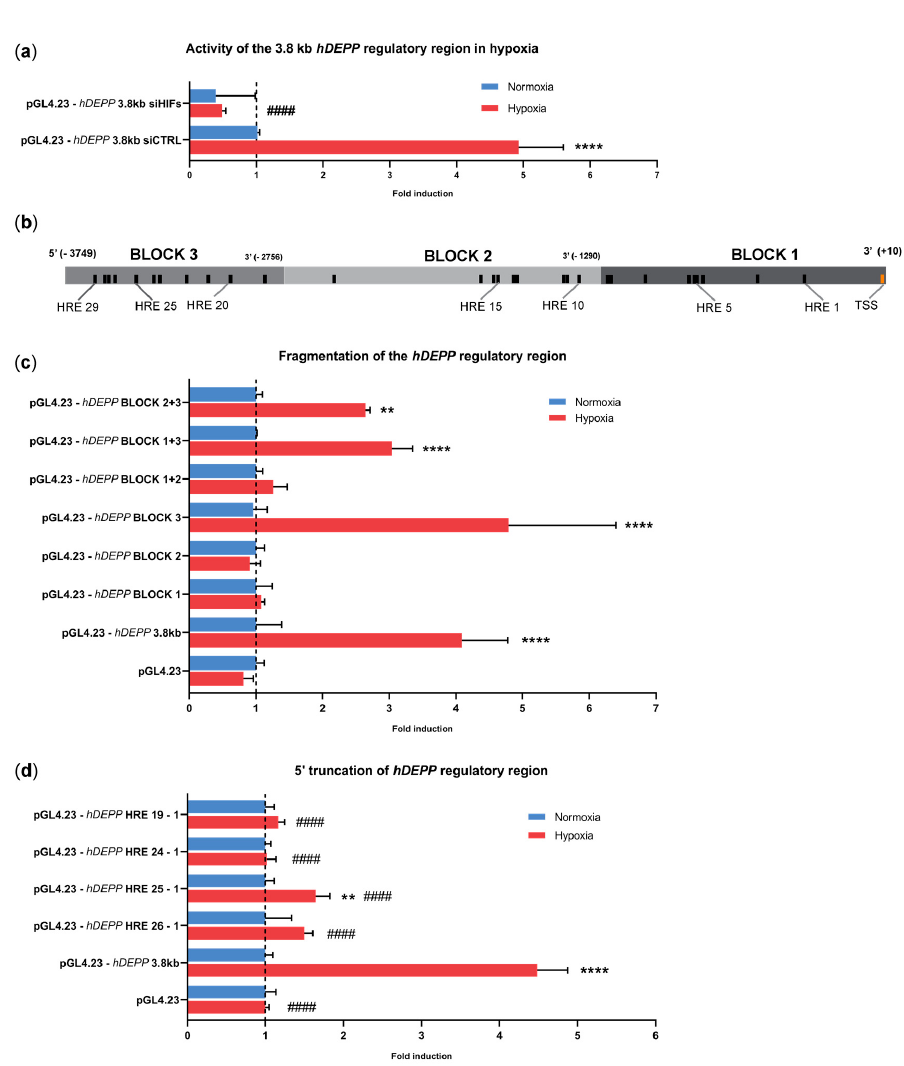
Figure 3. Hypoxic regulation by the 3.8 kb DNA fragment upstream of the DEPP transcriptional start site. ( a ) Luciferase activity driven by the 3.8 kb h DEPP regulatory region assayed in hypoxic and normoxic ARPE-19 cells. Cells were transfected with the reporter plasmid containing DEPP regulatory sequence and treated with scrambled siRNA (siCTRL) or with siRNAs against HIF1A and HIF2A (siHIFs). Luciferase activity was expressed relatively to the activity in normoxic ARPE-19 cells treated with control siRNA (pGL4.23- hDEPP 3.8 kb siCTRL). ( b ) Schematic representation of the 3.8 kb DNA fragment isolated from ARPE-19 genomic DNA and cloned into the luciferase reporter vector pGL4.23. Putative HREs are shown as black bars. The HRE closest to the TSS is numbered as HRE 1 and the most distal one as HRE 29. Precise positions of the HREs are given in Table S1. The DNA fragment was subdivided into three BLOCKS, as indicated. ( c ) Luciferase activity in cells transfected with the indicated BLOCK constructs was expressed relative to the respective normoxic controls, which were set to 1. ( d ) Luciferase activity in cells transfected with 5 ′ truncated constructs. HRE numbers in the construct name indicate the presence of the respective HRE sequences. Luciferase activities were expressed relative to the respective normoxic controls, which were set to 1. All luciferase values were normalized to b-galactosidase activity from the co-transfected normalizer plasmid. The empty pGL4.23 plasmid served as negative control. HRE: hypoxia responsive element. Shown are means ± SD of N = 3. Statistics: One-way ANOVA with the Brown–Forsythe test, *: p ≤ 0.05, **: p ≤ 0.005, ***: p ≤ 0.005, ****: p ≤ 0.0005, ####: p ≤ 0.0005. Stars (*) denote significance between the hypoxic and normoxic activity of the indicated vector. Hashtags (#) indicate significance between the hypoxic activity of the indicated vector and hypoxic activity of the reporter vector containing the 3.8 kb regulatory region (pGL4.23-hDEPP3.8